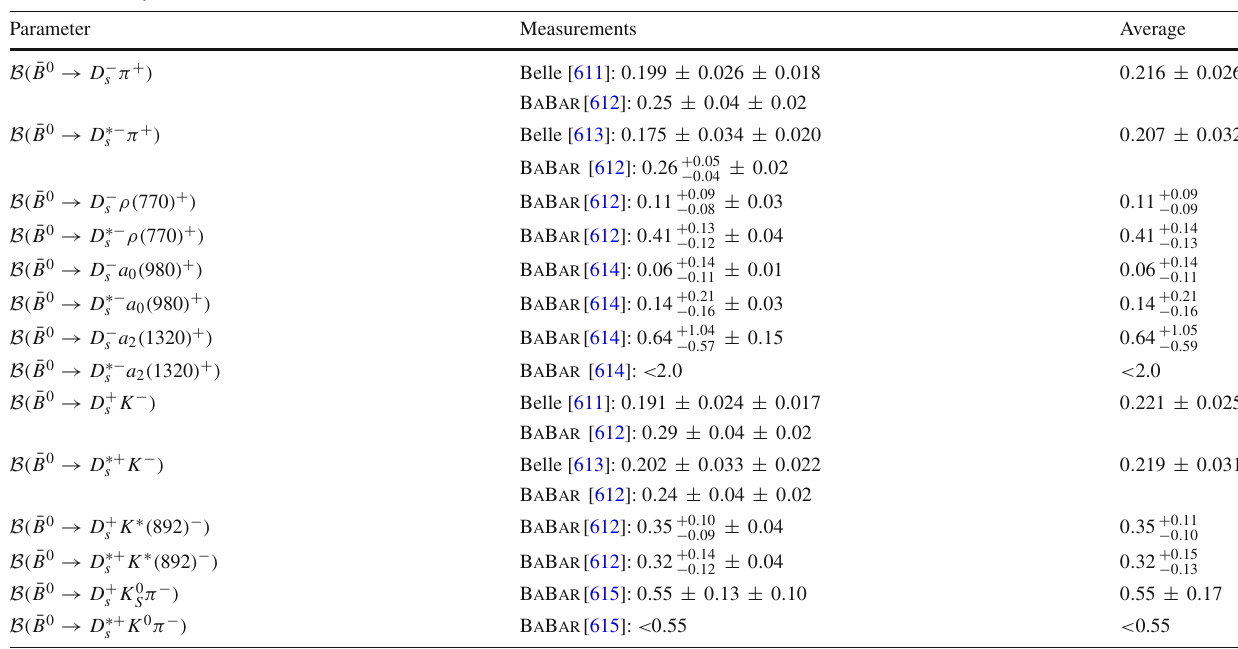
Table 98 Decays to a D